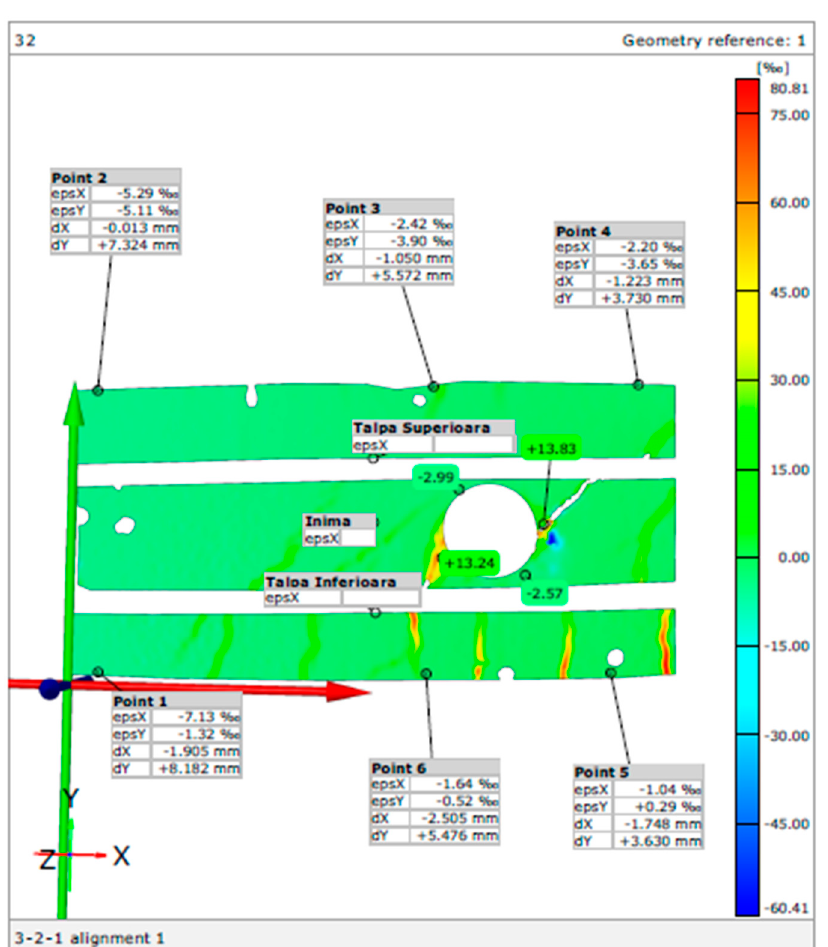
Figure 10. Experimental strains measured using the digital image correlation technique for fly ash beam (GR-3-CZ).